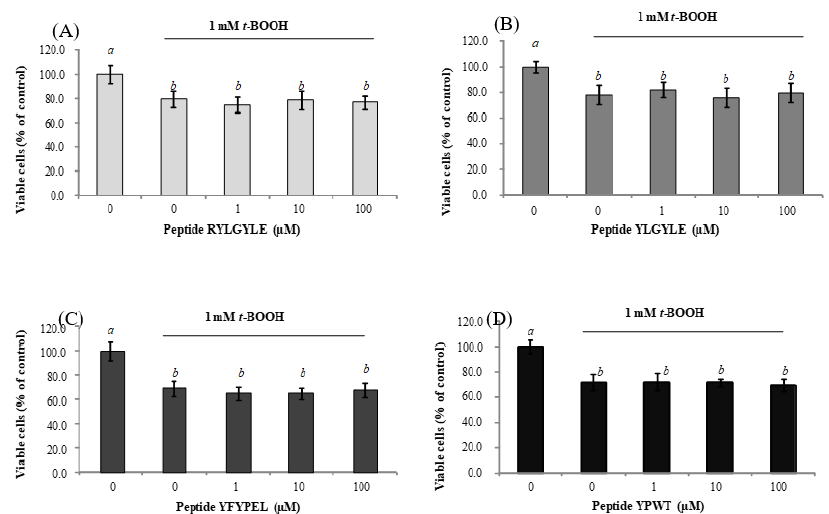
Figure 1. Dose-dependent effects of synthetic animal-protein derived peptides ( A ) RYLGYLE, ( B ) YLGYLE, ( C ) YFYPEL, and ( D ) YPWT on cell viability of stressed Caco-2 cells with 1 mM tert-butyl hydroperoxide ( t -BOOH). Cells were pre-treated with peptides at concentrations ranged from 1 to 100 μ M for 24 h. Results were expressed as the percentage of viable cells compared to control, which was considered as 100% (% control, mean ± standard deviation (SD), n = 3). Different letters indicate significant differences ( p < 0.05; Tukey multiple comparison test).